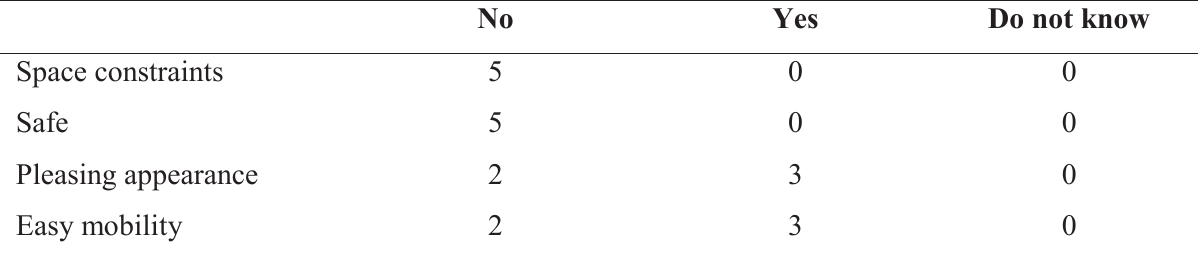
Table 7 - OR staff perception Questionnaire regarding to OR space, safety, appearance and mobility of Table 7 - Anesthesiogist Access to Patient Questionnaire.